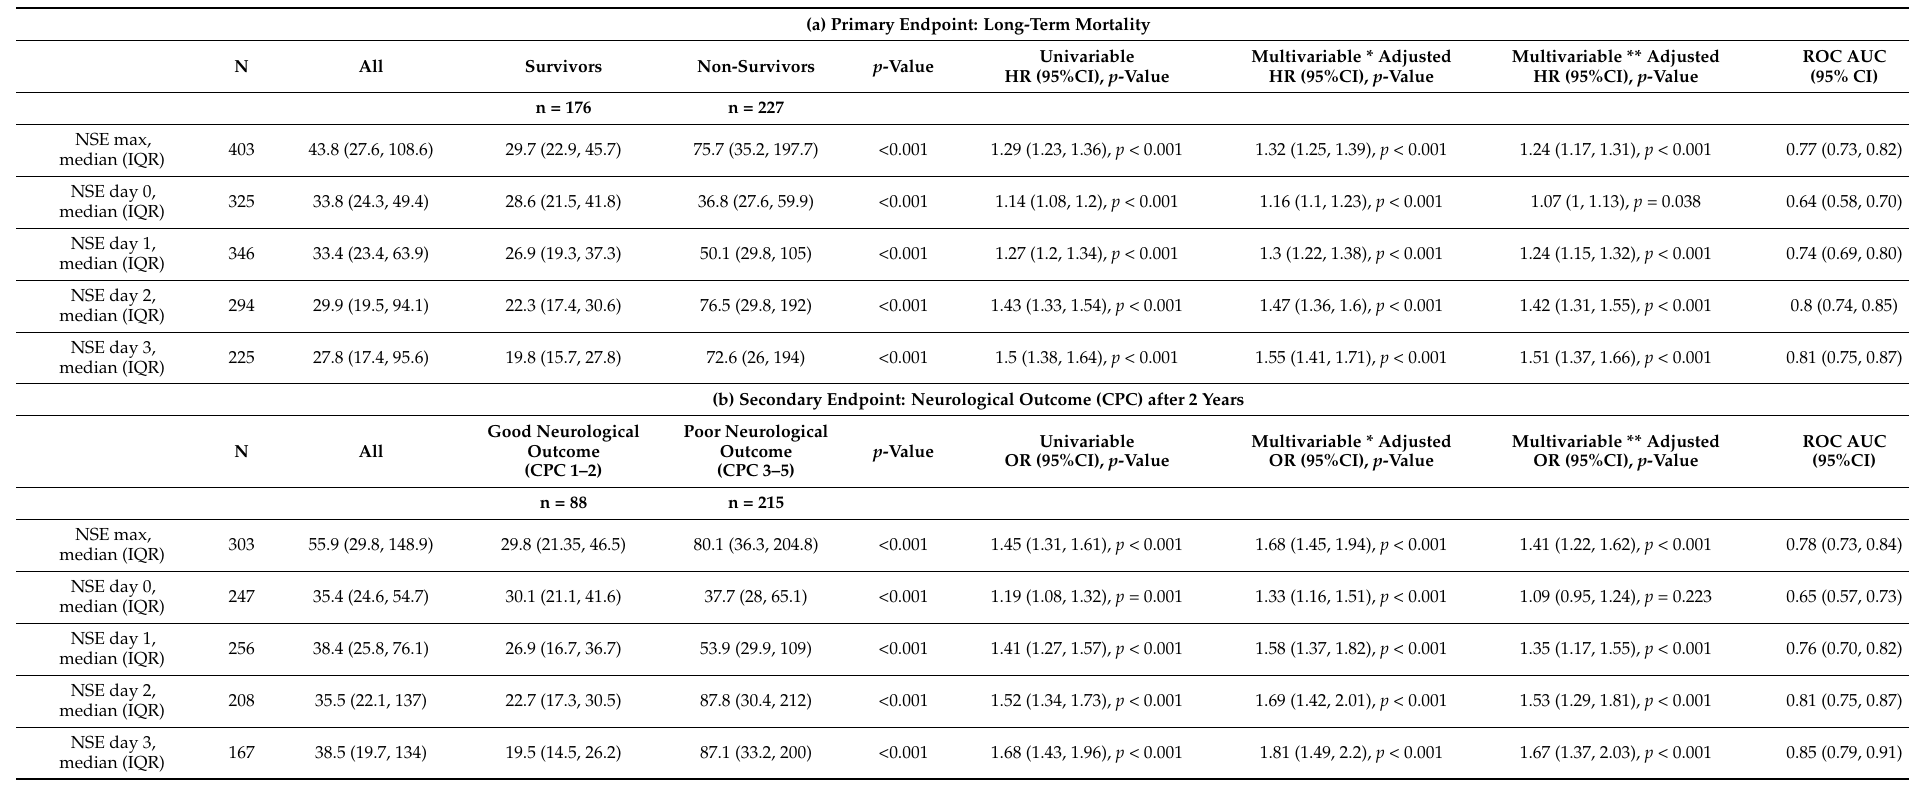
( a ) Comparison between NSE serum levels on different days to predict overall long-term mortality. Data presented as median (interquartile range) or mean (95% confidence interval). NSE, neuron specific enolase; HR, hazard ratio; ROC, receiver operating characteristics curve; AUC, area under the curve; IQR, interquartile range. * Adjusted for gender, age and comorbidities (coronary artery disease, congestive heart failure, COPD, hypertension, diabetes mellitus, chronic kidney disease, malignant disease, neurological disease). ** Adjusted for gender, age and resuscitation circumstances (ROSC, setting of cardiac arrest, bystander CPR, initial rhythm, initial lactate). ( b ) Comparison between NSE serum levels on different days to predict neurological outcome after two years. Data presented as median (interquartile range) ** Adjusted for gender, age and resuscitation circumstances (ROSC, setting of cardiac arrest, bystander CPR, initial rhythm, initial